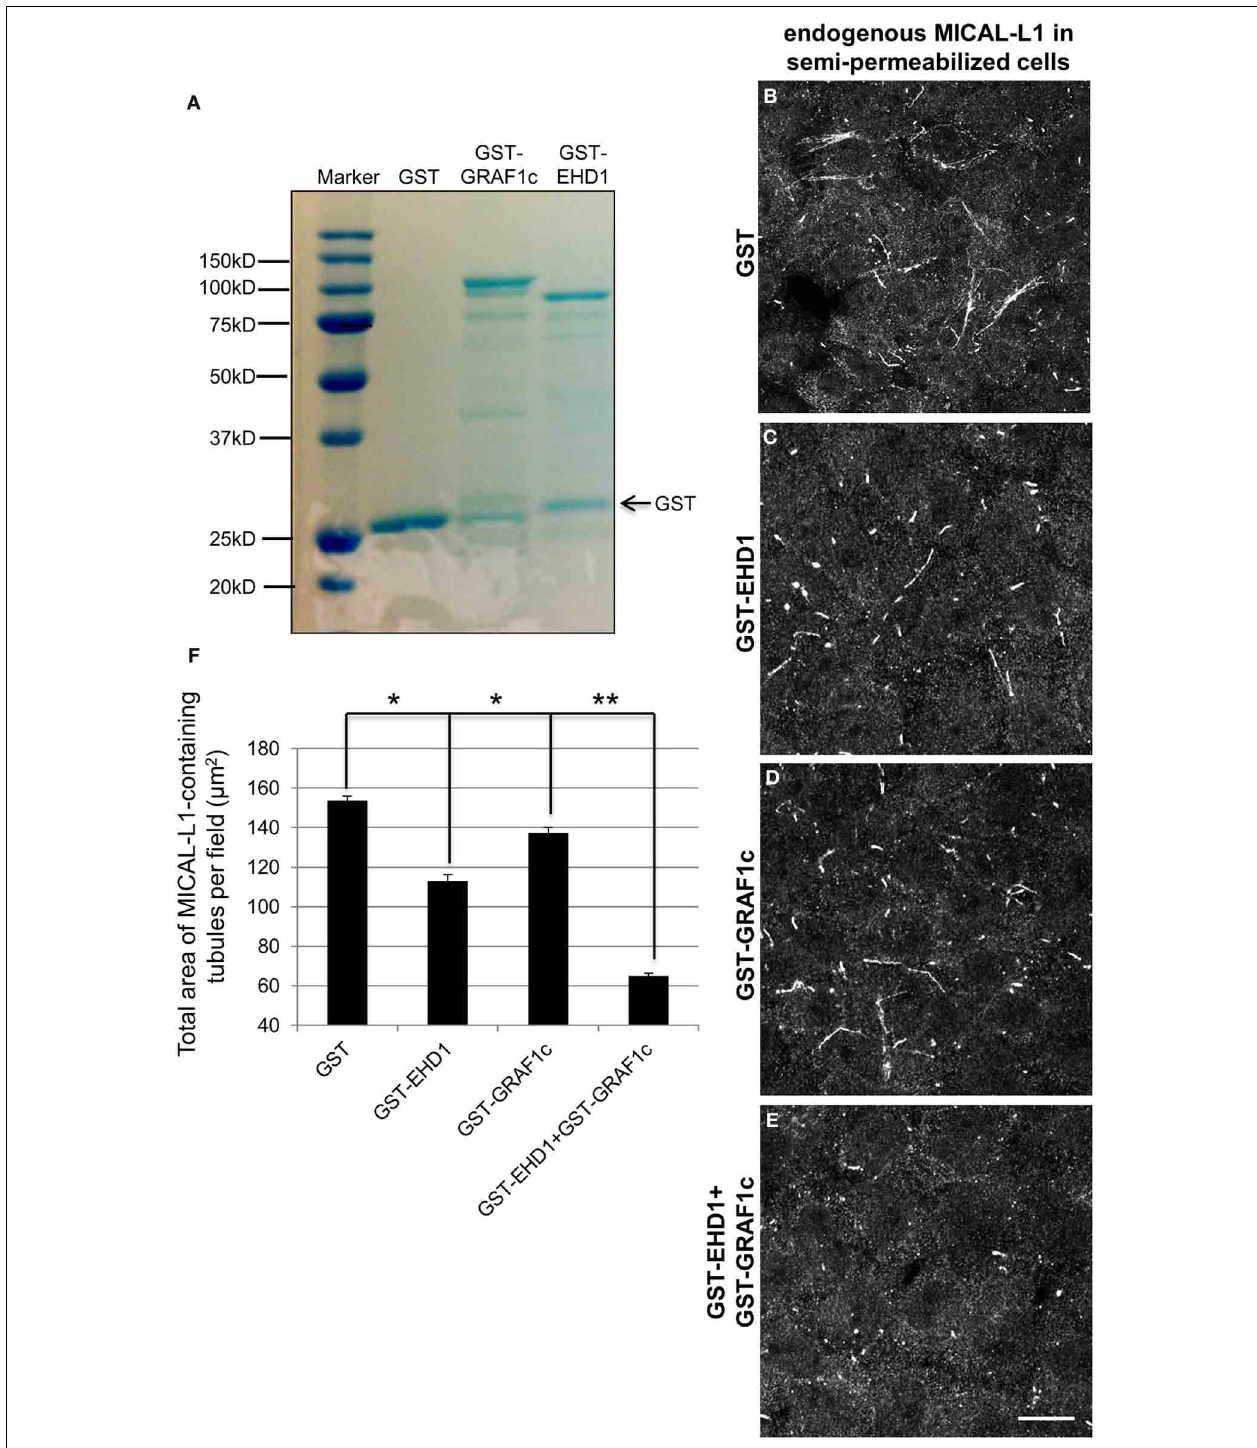
FIGURE 7 | GRAF1c and EHD1 vesiculate MICAL-L1-containing tubules synergistically in a semi-permeabilized cell system. (A) Purified GST only, GST-GRAF1c,andGST-EHD1weredetectedbySDS-PAGEandCoomassieBlue staining. (B–E) Cells were permeabilized with 20 μ g/ml digitonin for 40s at room temperature. Permeabilized cells were then either incubated for 30min.